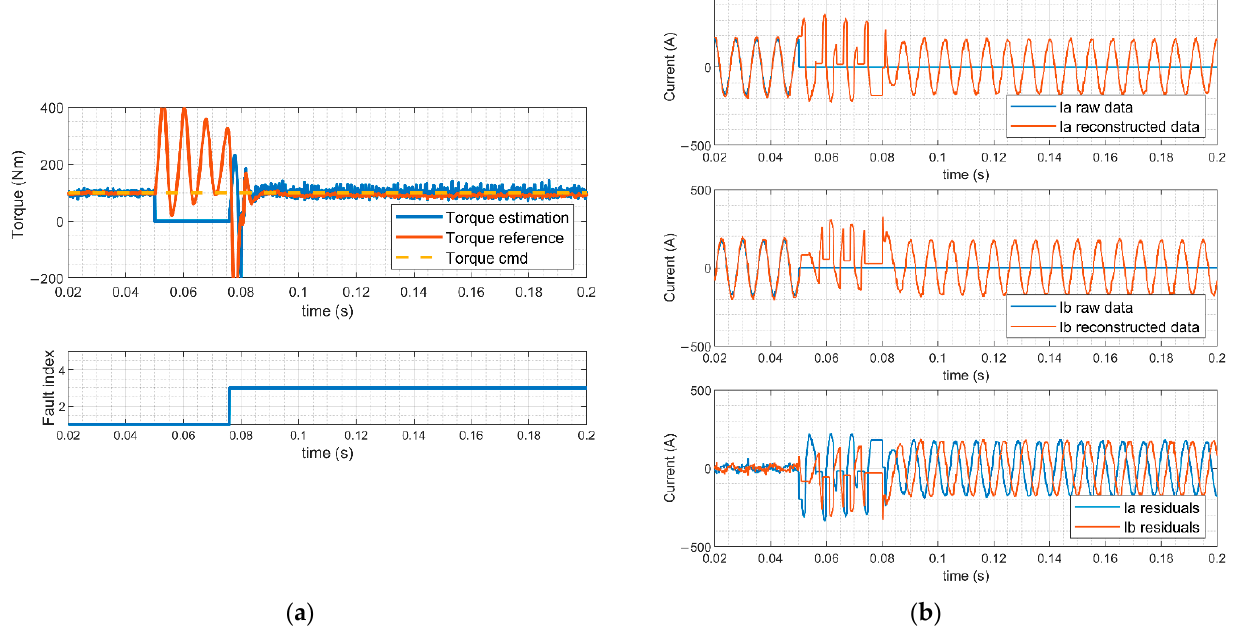
Figure 17. System response of simultaneous phase A current sensor and phase B current sensor fault. ( a ) Estimated and reference values of torque; ( b ) phase current A and B signal and its residual.